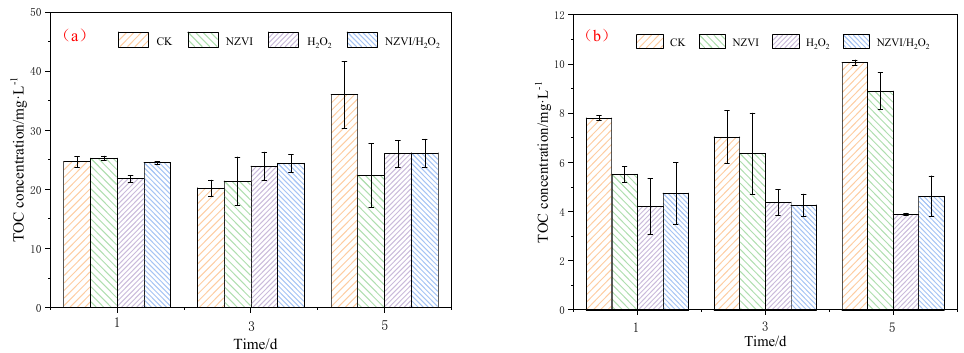
Figure 4. Verification of TOC for AOMs: ( a ) EOM and ( b ) IOM. Mean ± standard deviation of three replicates is shown for each value.